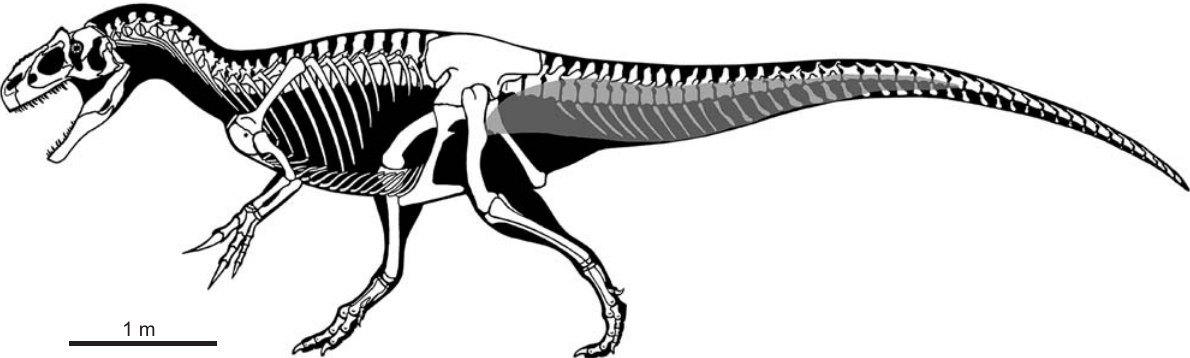
Fig. 2. Skeletal reconstruction of Allosaurus in lateral view, with reconstruction of caudofemoralis longus muscle (grey). Modified from drawing by Scott